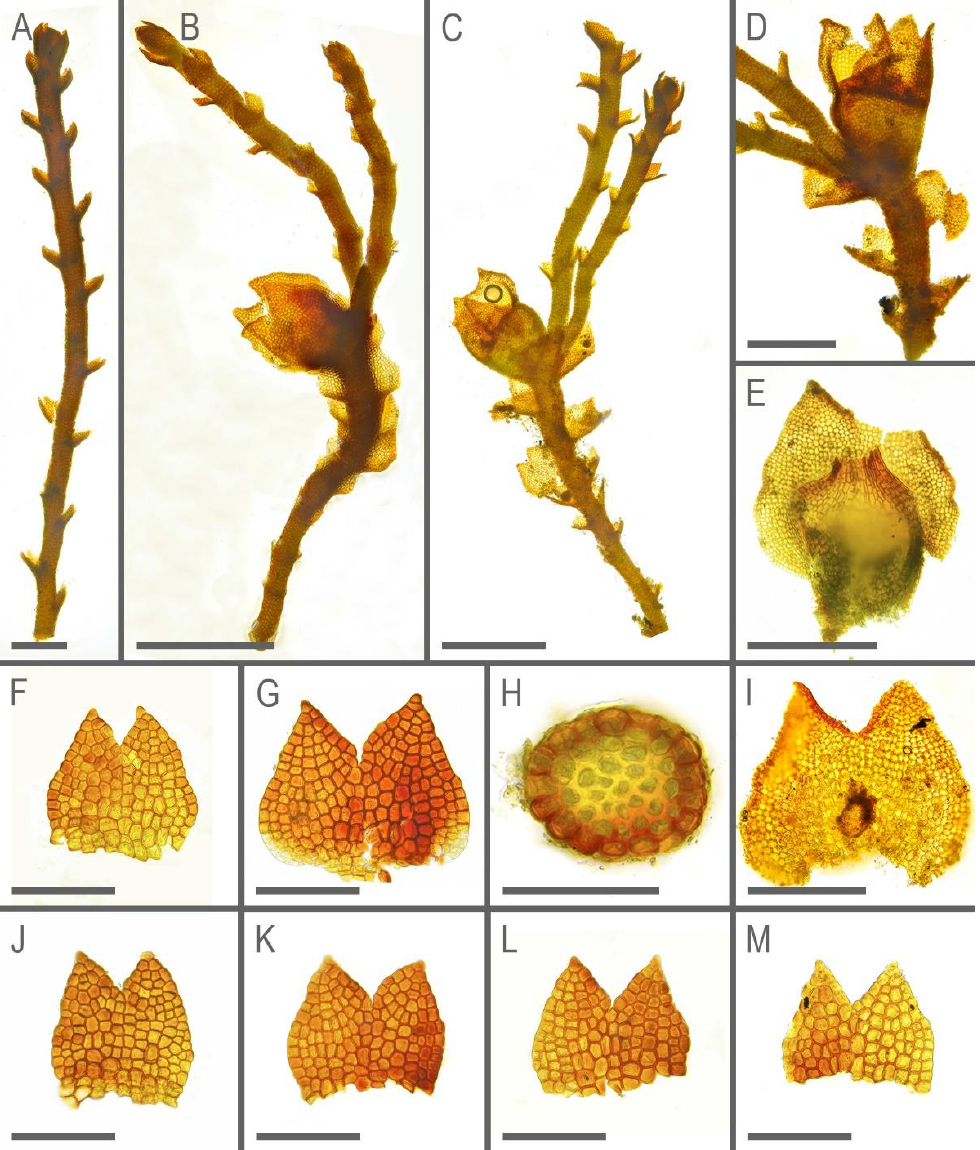
Figure 8. Marsupella taiwanica Mamontov, Vilnet et Schäf.-Verw. sp. nov .: ( A ) sterile shoot, fragment, dorsal view; ( B) perianthous plant, fragment, lateral view; ( C ) perianthous plant, fragment, ventral view; ( D) perianthous shoot, fragment, ventral view; ( E ) perianth with female bract; ( F , G , J – M ) leaves; ( H ) stem cross-section; ( I ) female bract. Scales: 100 µm for ( F – H , J – M ); 200 µm for ( A , I ); 300 µm for ( D , E ); 500 µm for ( B , C ). All from Holotype Schäfer-Verwimp 37,663 (MHA).